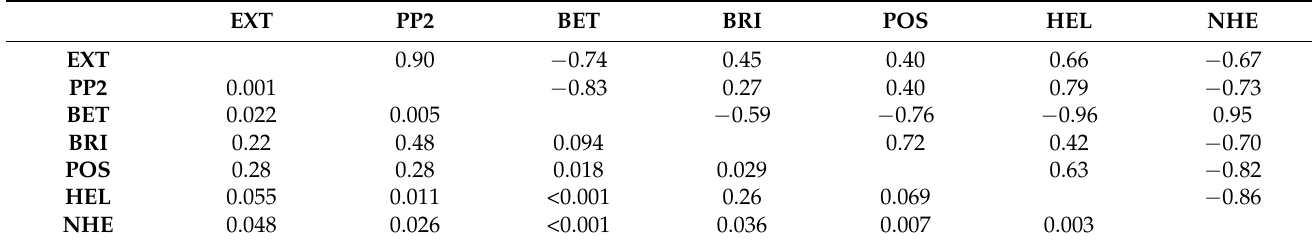
Table 1. Pair-wise comparison of the propensity scales for the ( ϕ , ψ ) clusters identified in the Ramachandran plot. The correlation coefficients R and the p -values are reported on the right and left sides of the diagonal, respectively. The ensemble of nine protein residues (A, V, L, I, M, K, R, Q, E) is considered.